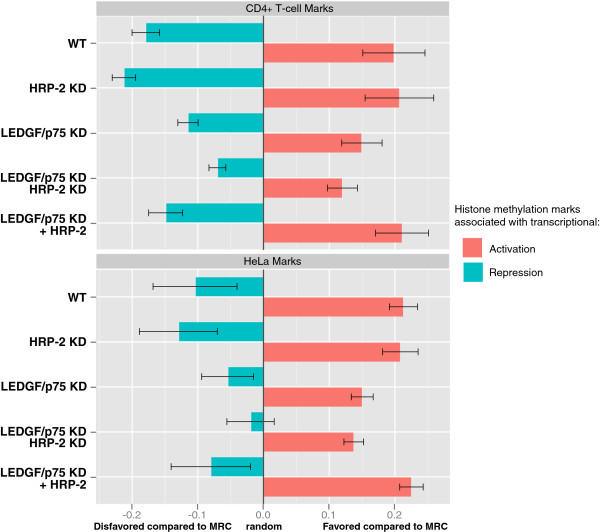
 LEDGF/p75 and HRP-2 depletion shifts integration towards random. A pooled score was determined for HIV-1 integration near epigenetic marks associated with transcriptional repression or activation for each cell line and plotted in a bar diagram. The X-axis represents deviation from random with positive values indicating favored integration compared to MRC, negative values disfavored integration compared to MRC. The pooled score is the average of the different ROC values - 0.5 (to indicate the deviation from random) obtained with individual markers (not shown) in a 10 kb window. For HeLaP4, H3K9me2, H3K9me3, H3K27me3, and H4K20me3 were pooled as associated with ‘repression’; H2BK5me1, H3K4me1, H3K36me3, H4K20me1 were pooled as associated with ‘activation’. For CD4+ T-cells, H3K9me2, H3K9me3, H3K27me2, H3K27me3, H3K79me3 and H4K20me3 were pooled as associated with ‘repression’; H2BK5me1, H3K4me1, H3K4me2, H3K9me1, H3K27me1, H3K36me3, H4K20me1 were pooled as associated with ‘activation’.